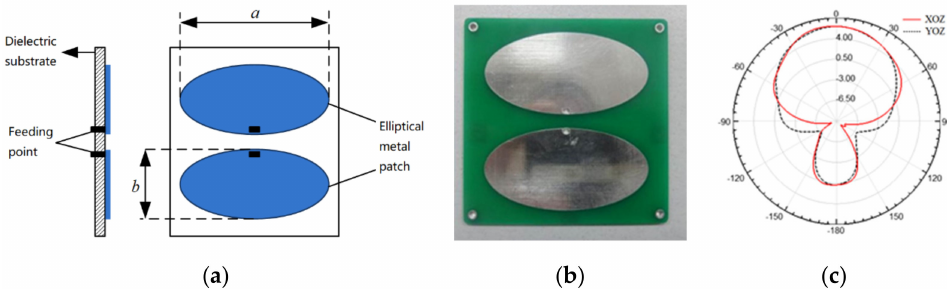
Figure 1. Designed ultra-high frequency (UHF) antenna: ( a ) diagram of antenna structure; ( b ) picture of printed circuit board (PCB) antenna; ( c ) radiation pattern at 1100 MHz.